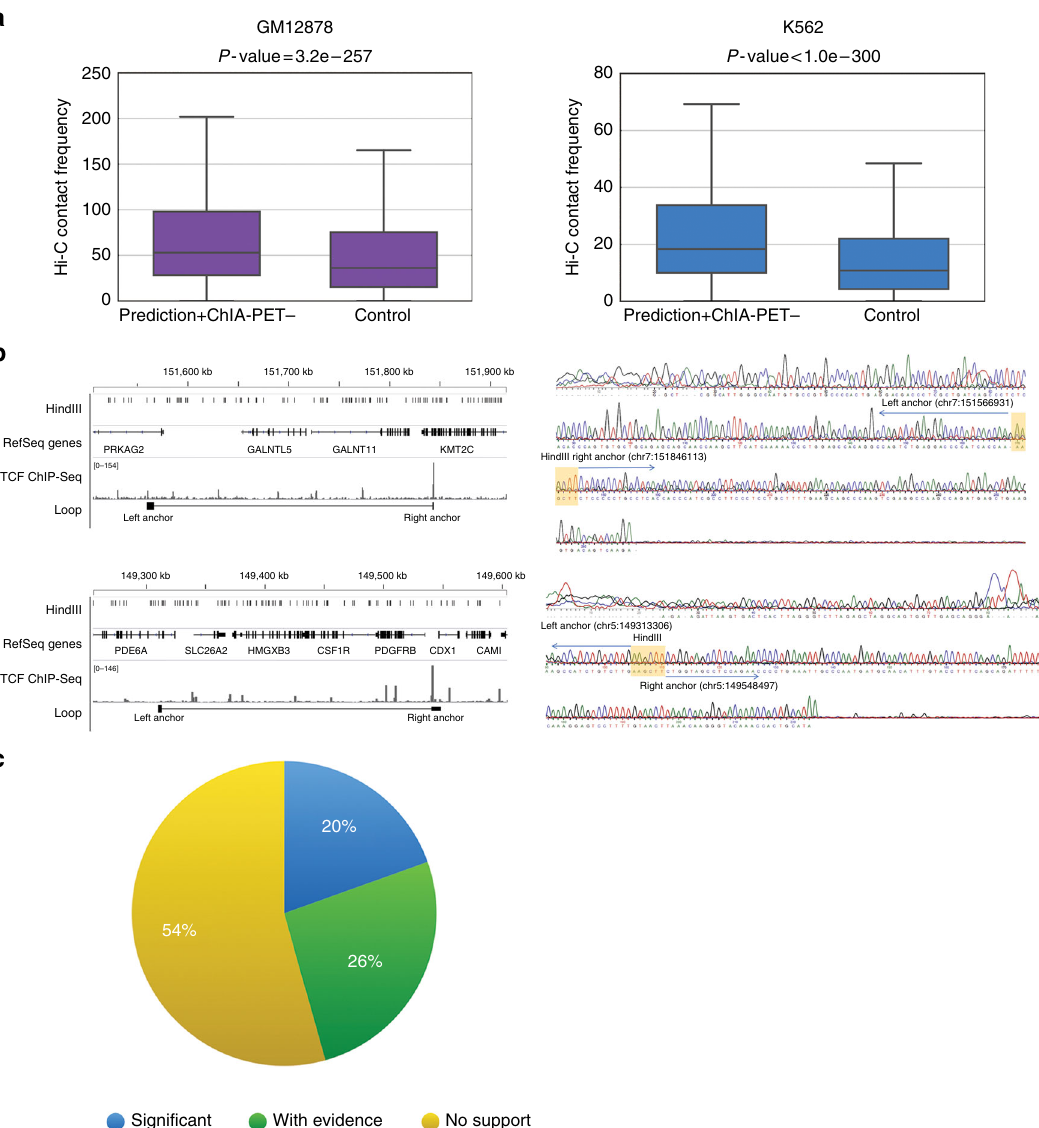
Fig. 6 Validation of predicted CTCF-mediated interactions. a CTCF-mediated loops predicted by Lollipop but lacking ChIA-PET support exhibit signi fi cantly higher contact frequency than background in Hi-C experiments. P- values were calculated using Mann – Whitney U -test. b Validation of two loops predicted by Lollipop, but not present in the HeLa ChIA-PET data set. Left: schematic of PRKAG2-KMT2C (chr7: 151560677 – 151843260; top) and PDE6A-PDGFRB loop (chr5: 149312517 – 149547724; bottom). Right: Sanger sequencing con fi rmation of the ligation junctions. Shaded areas in the right panels indicate the HindIII ligation junctions. c Scaling analysis of loop prediction. Loops predicted using a model trained on the down-sampled (to 15%) GM12878 data, but lacks support in the down-sampled data (i.e., the yellow slice in Supplementary Fig. 5d) are evaluated by the full ChIA-PET data. Forty-six percent of